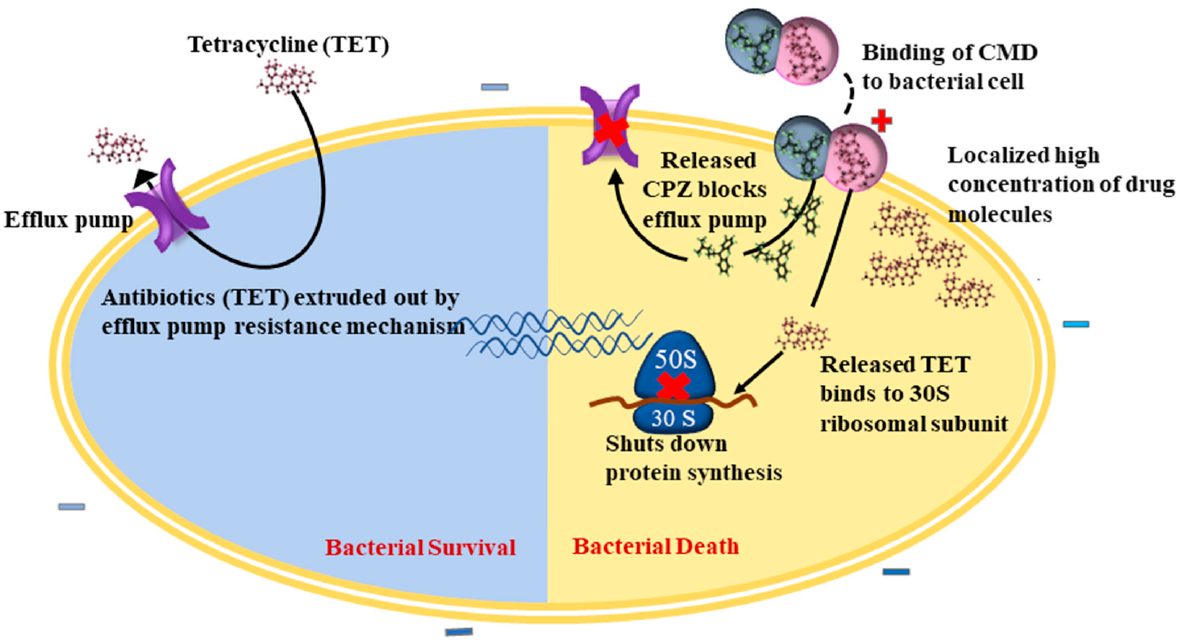
Figure 6. Mechanism of action of CMD on the bacterial cell. Positively charged CMD binds to negatively charged bacterial cells and releases TET and CPZ. CPZ blocks the efflux pumps and inhibits the extrusion of TET. TET binds to the 30S ribosomal subunit and shuts down the protein synthesis, leading to cell death.